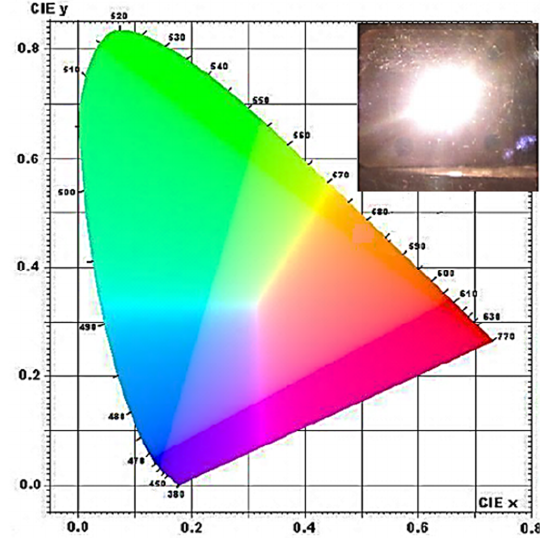
Figure 11. CIE color diagram and point of the color space (black circle) corresponding to the color coordinates of the WL emission (shown in the inset) observed by un-doped Y 2 O 3